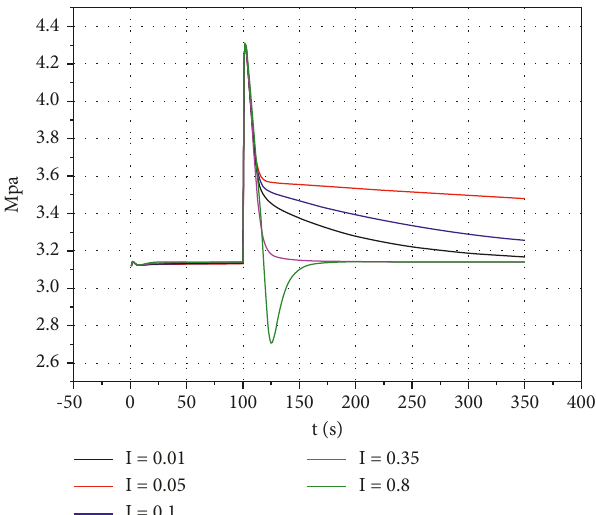
Figure 5: The changes of pressure at different I when P and D are fixed.